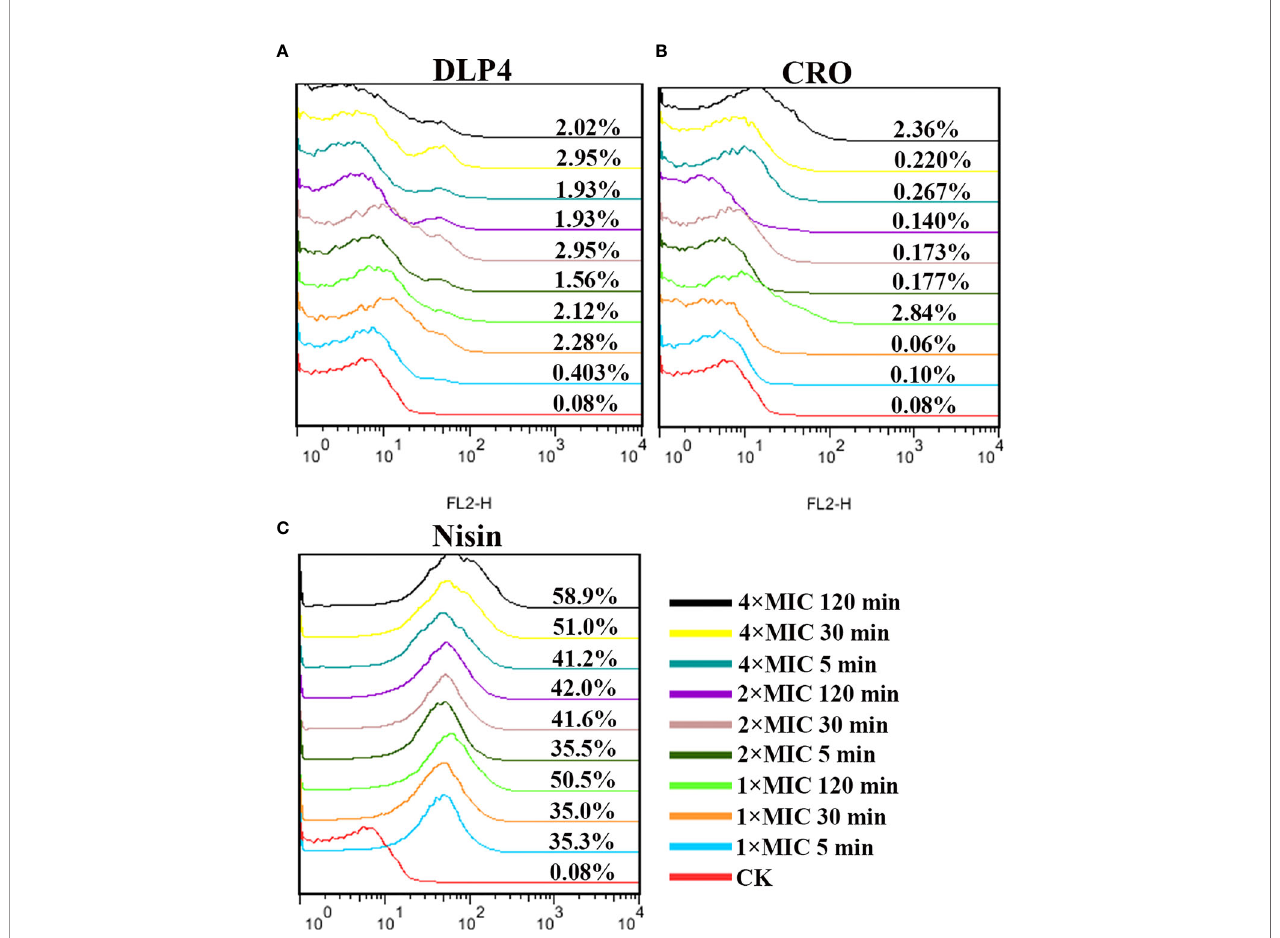
FIGURE 3 | Analysis of PI-staining in S. hyicus ACCC 61734 treated with DLP4. (A) Analysis of PI-staining in S. hyicus ACCC 61734 treated with DLP4. (A) Pathogen treated with 1×, 2× and 4× MIC DLP4 for 5, 30 and 120 min, respectively; (B) Pathogen treated with 1×, 2× and 4× MIC CRO for 5, 30 and 120 min, respectively; (C) Pathogen treated with 1×, 2× and 4× MIC Nisin for 5, 30 and 120 min,